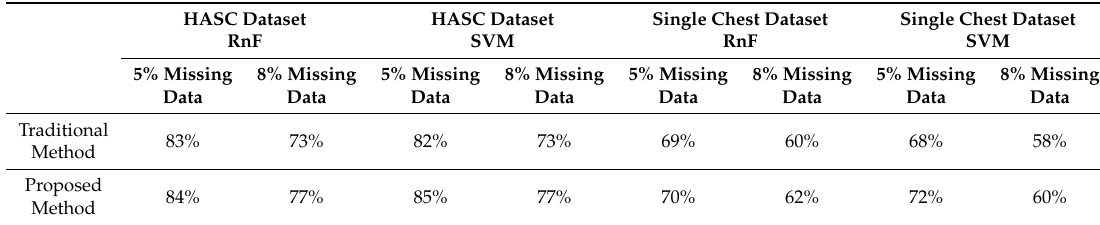
Table 2. Result analysis having 5% and 8% Missing data in both